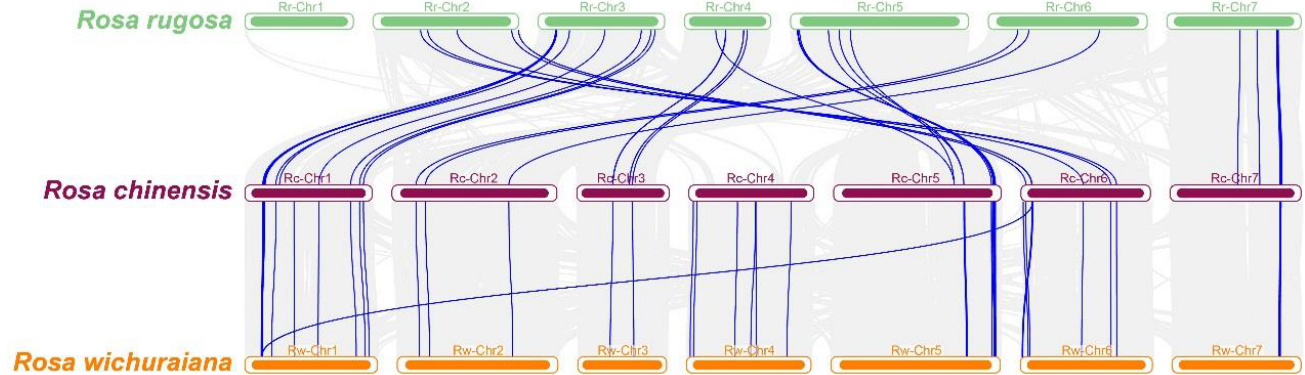
Figure 6. Collinearity of R. chinensis with Rosa rugosa ( R. rugosa ) and Rosa wichuraiana ( R. wichuraiana ). Chromosomes of R. rugosa , R. chinensis , and R. wichuraiana are indicated by green, purple, and orange bars, respectively, and are arranged by chromosome number from low (left) to high (right). The blue lines between the chromosomes of the different species indicate collinearity blocks with RcTNL genes, and the gray lines indicate blocks of collinearity between genomes.